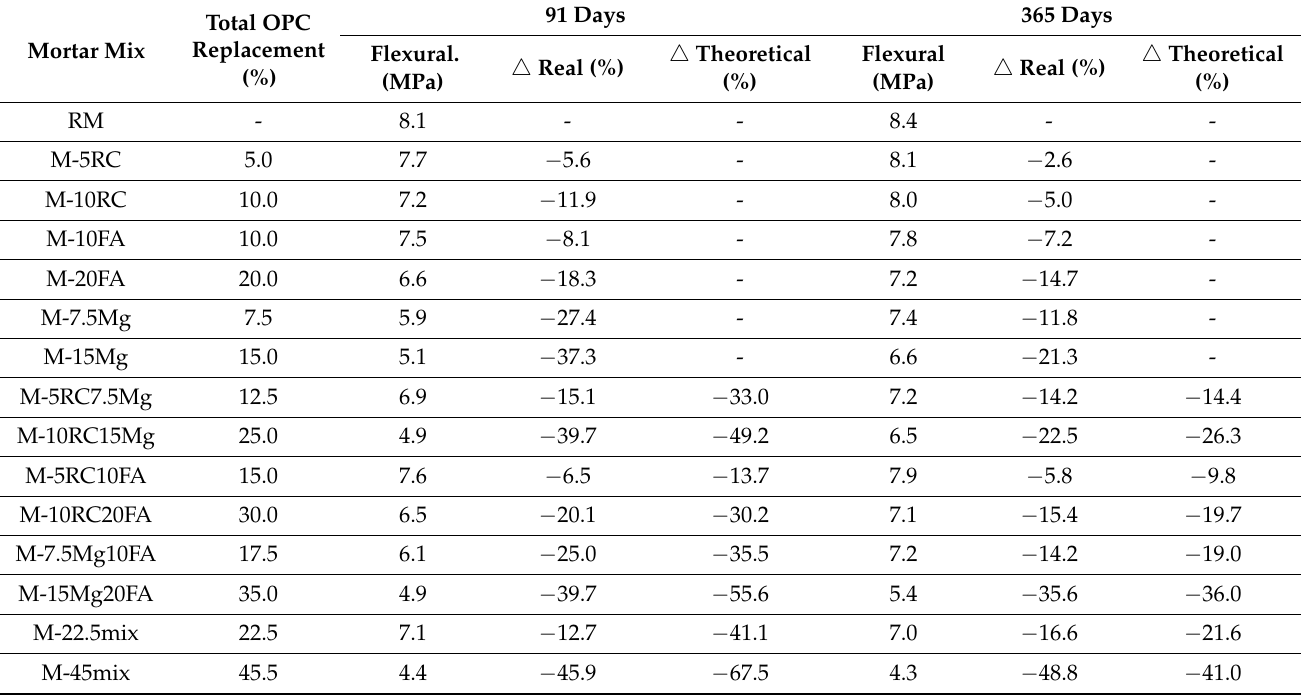
Table 7. Flexural strength between 91 and 365 days of curing.